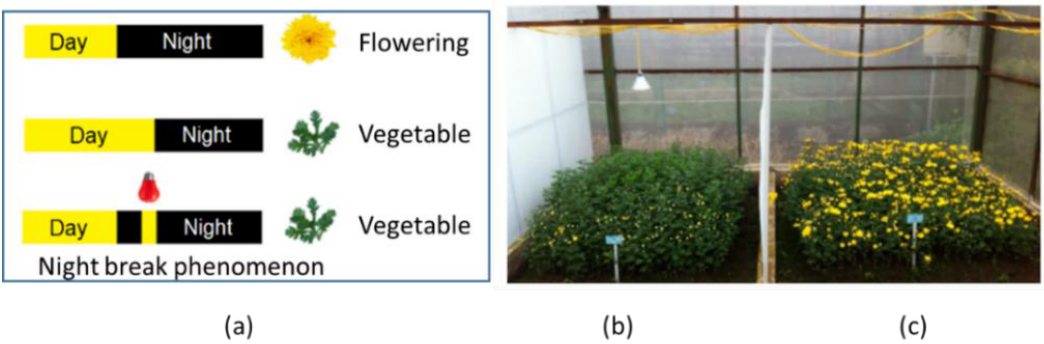
Figure 15. Night break phenomenon ( a ) Principle; ( b ) Chrysanthemum with controlled flowering by LED. ( c ) Chrysanthemum without controlled flowering.